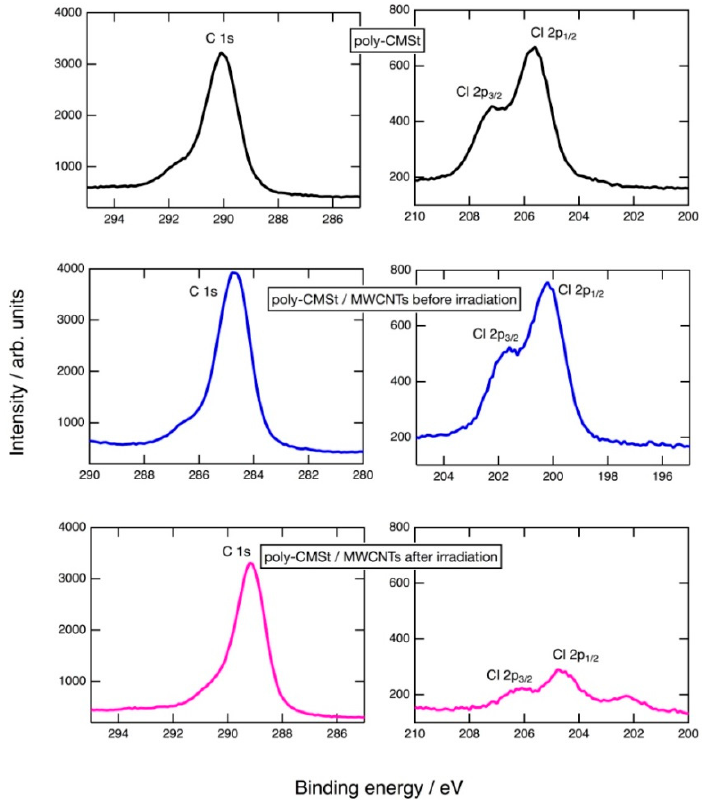
Figure 6. C 1s and Cl 2p X-ray photoelectron spectra observed for intact poly(p-chloromethyl)styrene (poly-CMSt) and for poly-CMSt/multi-walled carbon nanotube mixture containing NH 2 OH···HCl, before and after ultraviolet irradiation.